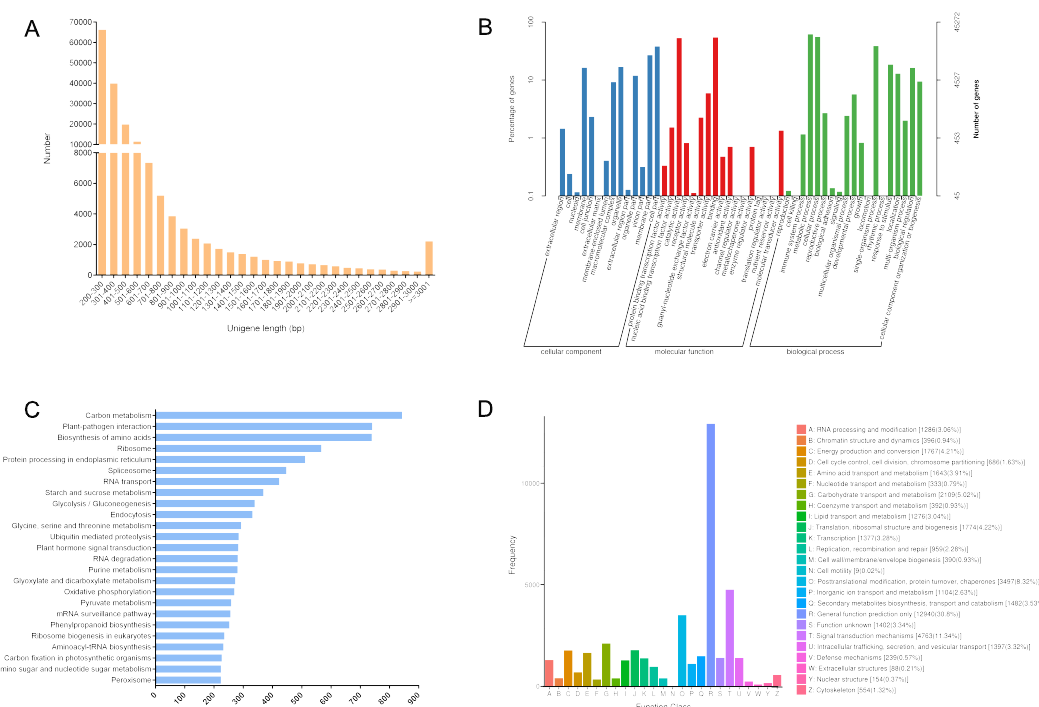
Figure 1. Unigene length and classification. ( a ) Distribution of unigene length. ( b ) Unigene functional ————————– ————————– ————————– 48 annotations based on the gene ontology database. ( c ) Top 25 enriched KEGG pathways among the unigenes. ( d ) Classifications based on the Clusters of Orthologous Group